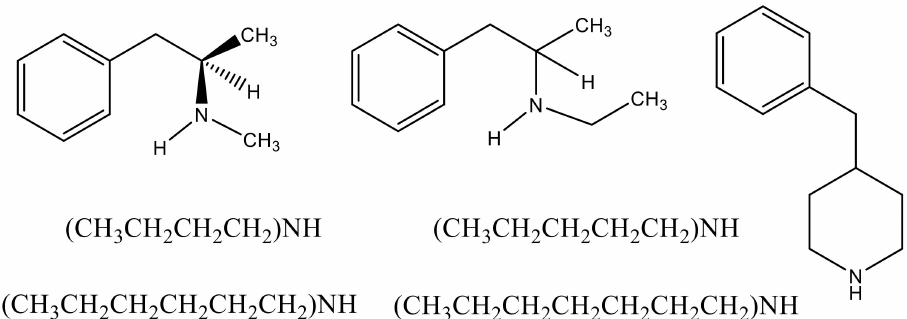
Figure 1. Left to right: ( dl ) S (+)-methamphetamine, ( dl )- N -ethylamphetamine, 4-benzylpiperidine; N , N -dibutylamine, N , N -dipentylamine; N , N -dihexylamine, N , N -diheptylamine.